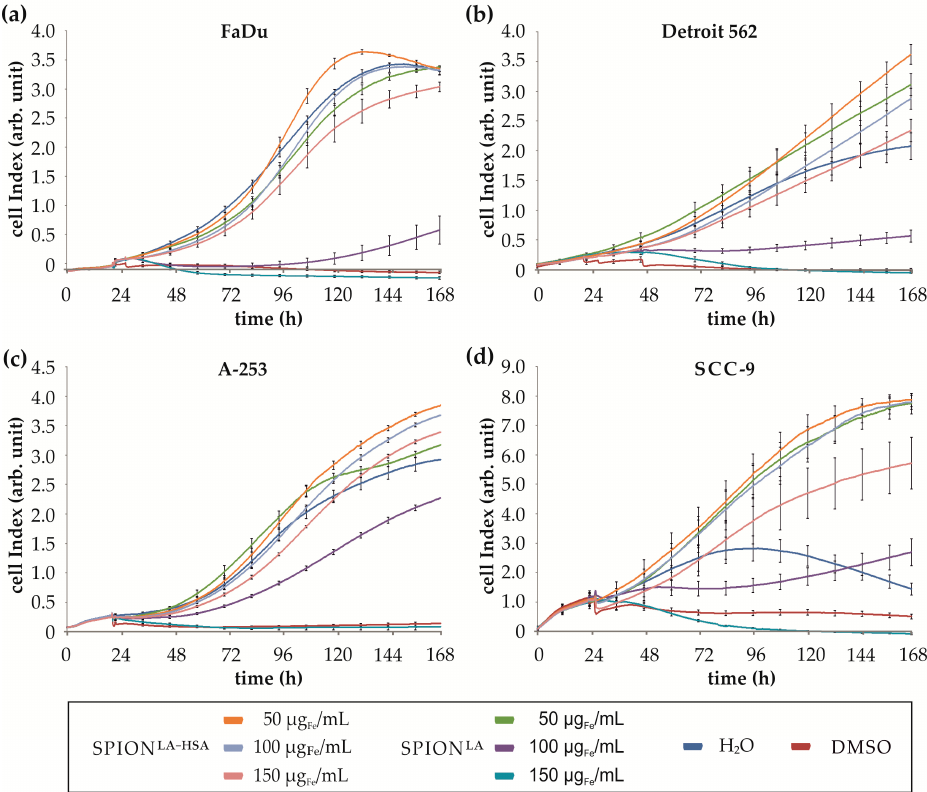
Figure 7. Impedance-based real-time analysis of cell growth. Growth curves of FaDu ( a ), Detroit 562 ( b ), A253 ( c ) and SCC-9 ( d ) cells were generated by monitoring the change in impedance after addition of SPION LA or SPION LA-HSA at concentrations of 50, 100 and 150 µg Fe /mL cell culture medium. The positive control contains 2% DMSO, and the negative control H 2 O instead of the SPION suspension. Data are expressed as standard error of the mean ( n = 4 with 8-fold replicates). Abbreviations: SPION, superparamagnetic iron oxide nanoparticles; SPION LA , lauric acid-coated SPIONs; SPION LA-HSA , lauric acid- and human serum albumin-coated SPIONs; arb. unit, arbitrary unit.